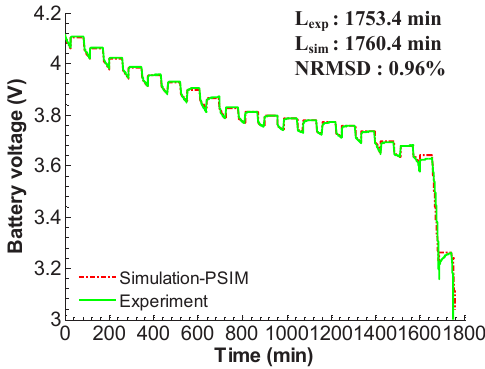
Figure 15. Validation of the 0.1 C discharge-relaxation